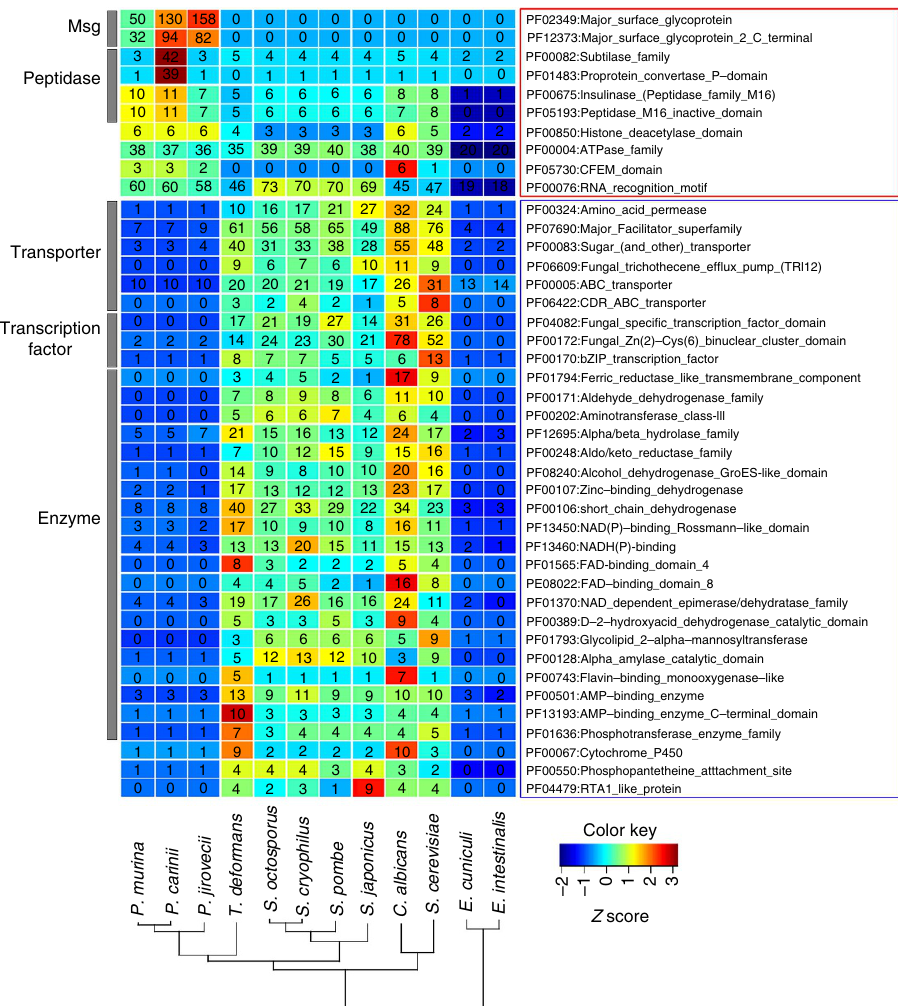
Figure 2 | Protein domains depleted or enriched in Pneumocystis . Significantly enriched (top panel) or depleted (lower panel) Pfam domains (Fisher’s exact test, q value o 0.05) are included in the heat map if the domains appear at least twice in the following comparisons: Pneumocystis versus Schizosaccharomyces , Pneumocystis versus Schizosaccharomyces and T. deformans , Pneumocystis versus S. cerevisiae and C. albicans , Pneumocystis versus E. cuniculi and E. intestinalis , Pneumocystis versus all others shown. Broader functional categories of proteins are indicated on the left, while specific Pfam domains are listed on the right. The number of proteins containing each domain is indicated within each box for each species. The heat map is colour coded based on a Z score, as indicated by the key at the bottom right. Fungal species are ordered based on their phylogenetic relationship as indicated at the